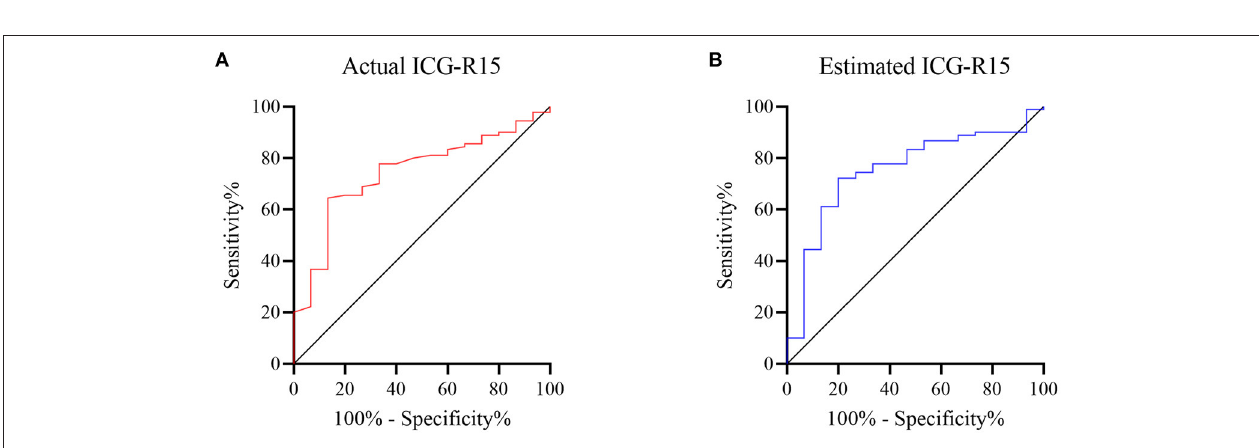
FIGURE 3 | ROC curves of actual and estimated indocyanine green retention rate at 15min [ICG-R15(XGBR)] for predicting post hepatectomy liver failure (PHLF) grades B-C. Receiver operating characteristic (ROC) analysis was used to evaluate the performance of actual and estimated ICG-R15(XGBR) for predicting PHLF grades B-C. The area under ROCs of actual (A) and estimated ICG-R15(XGBR) (B) were 0.74 and 0.75, respectively. ROC, receiver operating characteristic; ICG-R15, indocyanine green retention rate at 15min; XGBR, extreme gradient boosting regression model; PHLF, post hepatectomy liver failure. and sensitivity and specificity were 90.91% [95% confidence intervals (CI): 83.07, 95.32%) and 100% (95% CI: 81.57, 100%)], respectively. Similarly, for RFR and ANN model, the predictive performance was 93.18% (95% CI: 85.91, 96.84%) and 100% (95% CI: 81.57, 100%), and 97.73% (95% CI: 92.09, 99.6%) and 88.24% (95% CI: 65.66, 97.91%),